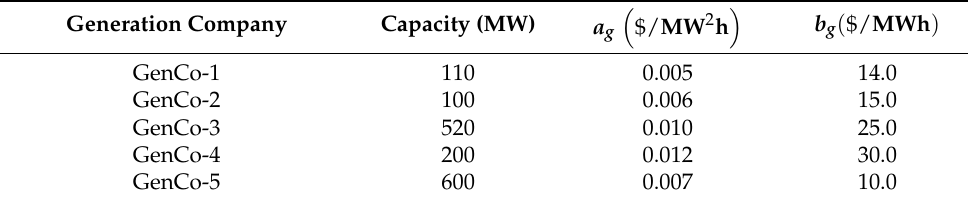
Table 4. Capacities and Cost Coefficients of Generators [50].